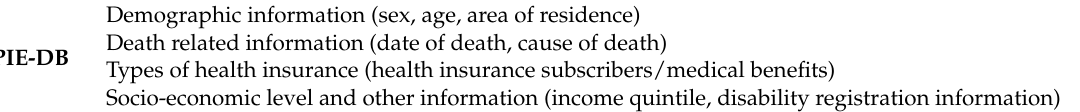
Table 3. KNHIS-SC DB